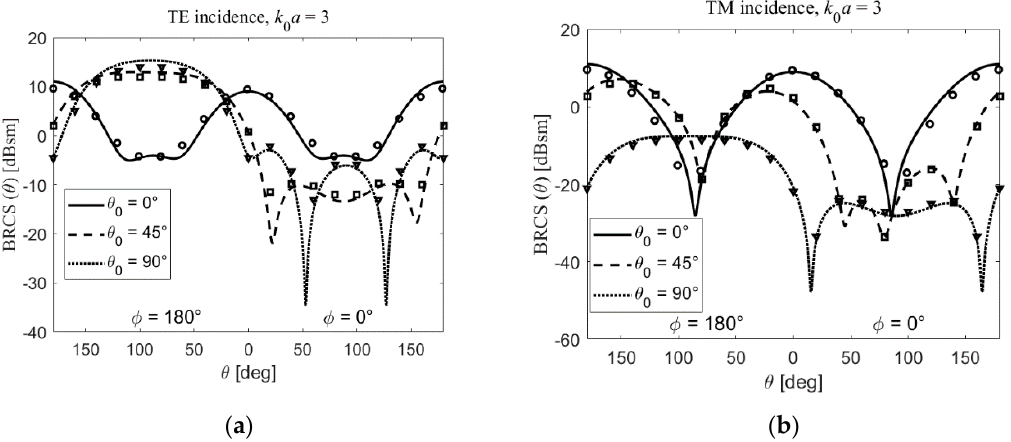
Figure 6. Effective ( a ) electric and ( b ) magnetic currents on a disk along the x axis for three incidence directions ( θ 0 = 0 ◦ ,45 ◦ ,90 ◦ and φ 0 = 0 ◦ ). k 0 a = 3, τ = 0.05 a , ε = ( 10.5 − j 0.3 ) ε 0 , µ = µ 0 and TM incidence.